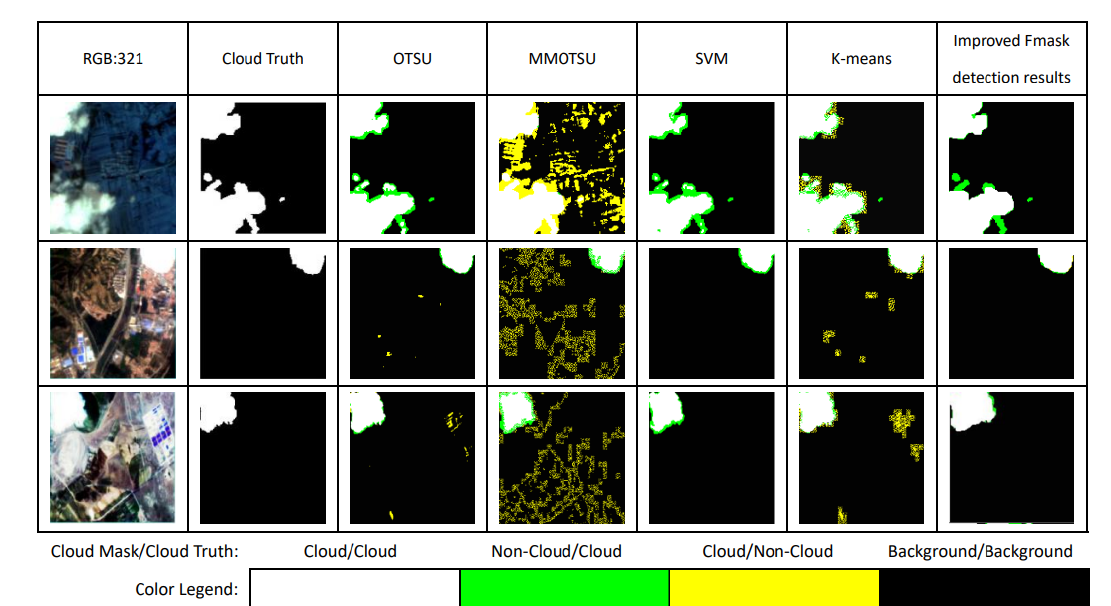
Figure 10. Compare the results of different cloud detection methods on images of cultivated land, woodland and bare soil with bright